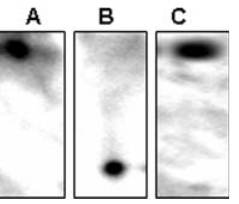
Figure 8. 2D immunoblot analysis of LDH. Activity bands were excised from BN PAGE experiment and ran on a 10% SDS-PAGE. A) Upper band (mitochondrial fraction). B) Lower band (mitochondrial fraction). C) Band from soluble fraction